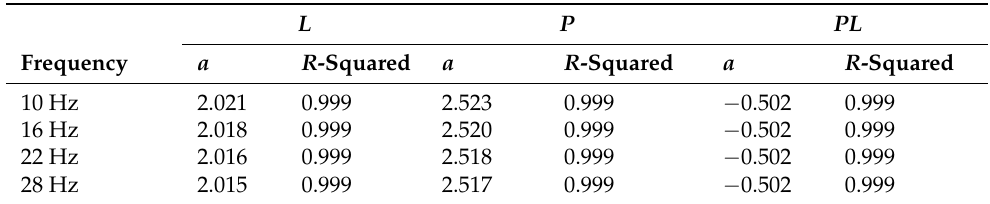
Table 6. Coefficients for the power relationship between aerodynamic performance and S at different flapping